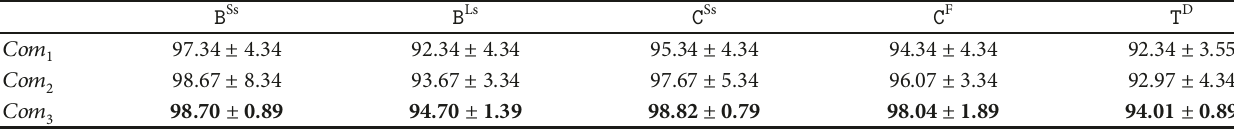
Figure 13: TP classification accuracies based on OOAGDFs. Table 3: SWDM-based classification accuracies based on the filter bank combination of OSIGDFs and